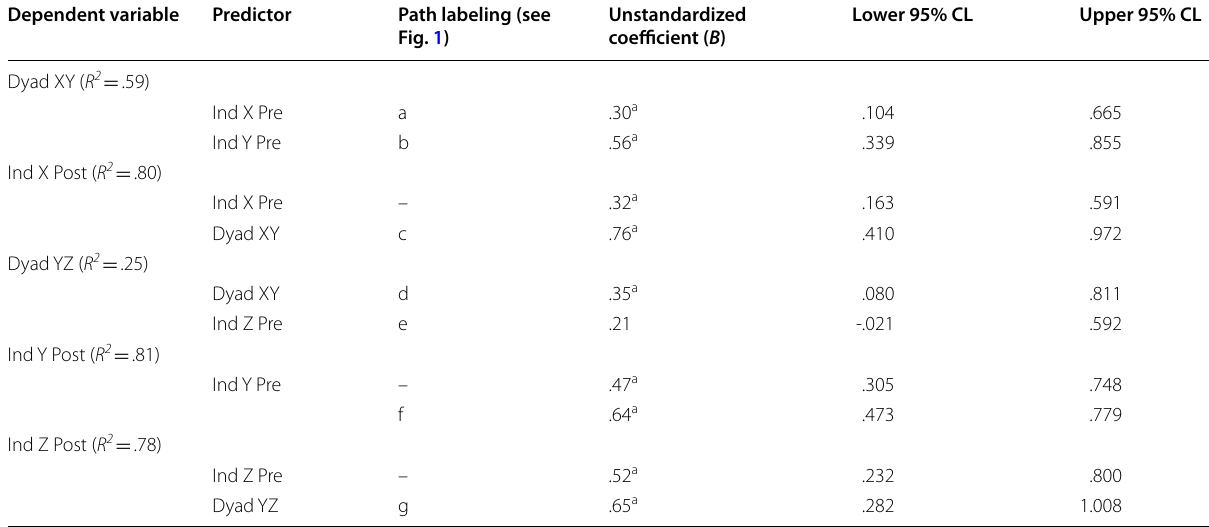
Paths labeled as “–” were not included in Fig. 1 for illustration purposes. CL confidence limit. Confidence limits were derived from 95% bias-corrected bootstrap confidience intervals based on 10,000 resamples. The significance of the path coefficients ( a ) was based on whether the confidence interval included zero or